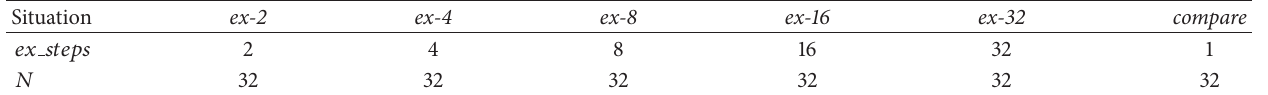
Table 12: Parameter list of different exchanging times but of equal sampling number.